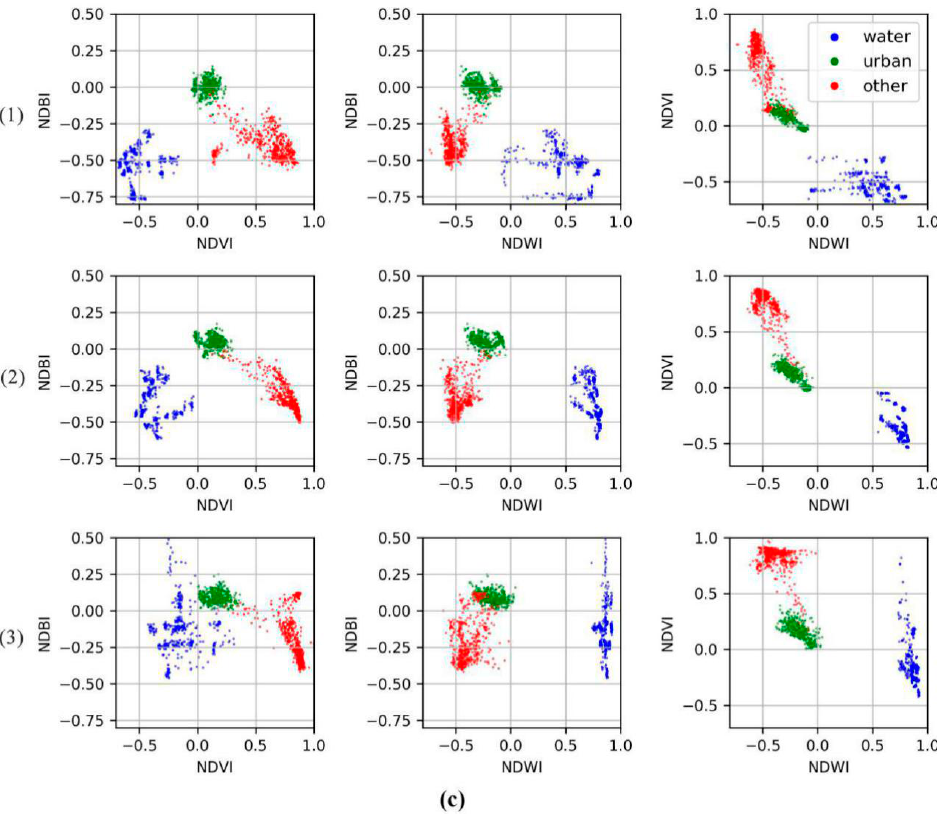
Figure 6. The scatter plot of the training sample points for different land cover types in the feature space composed of NDWI, NDVI, and NDBI (( a ), ( b ), and ( c ) represent Beijing, Xi’an, and Xiamen, respectively; (1), (2), and (3) represent the results from ee.Reducer.min(), ee.Reducer.median(), and ee.Reducer.max(), respectively).